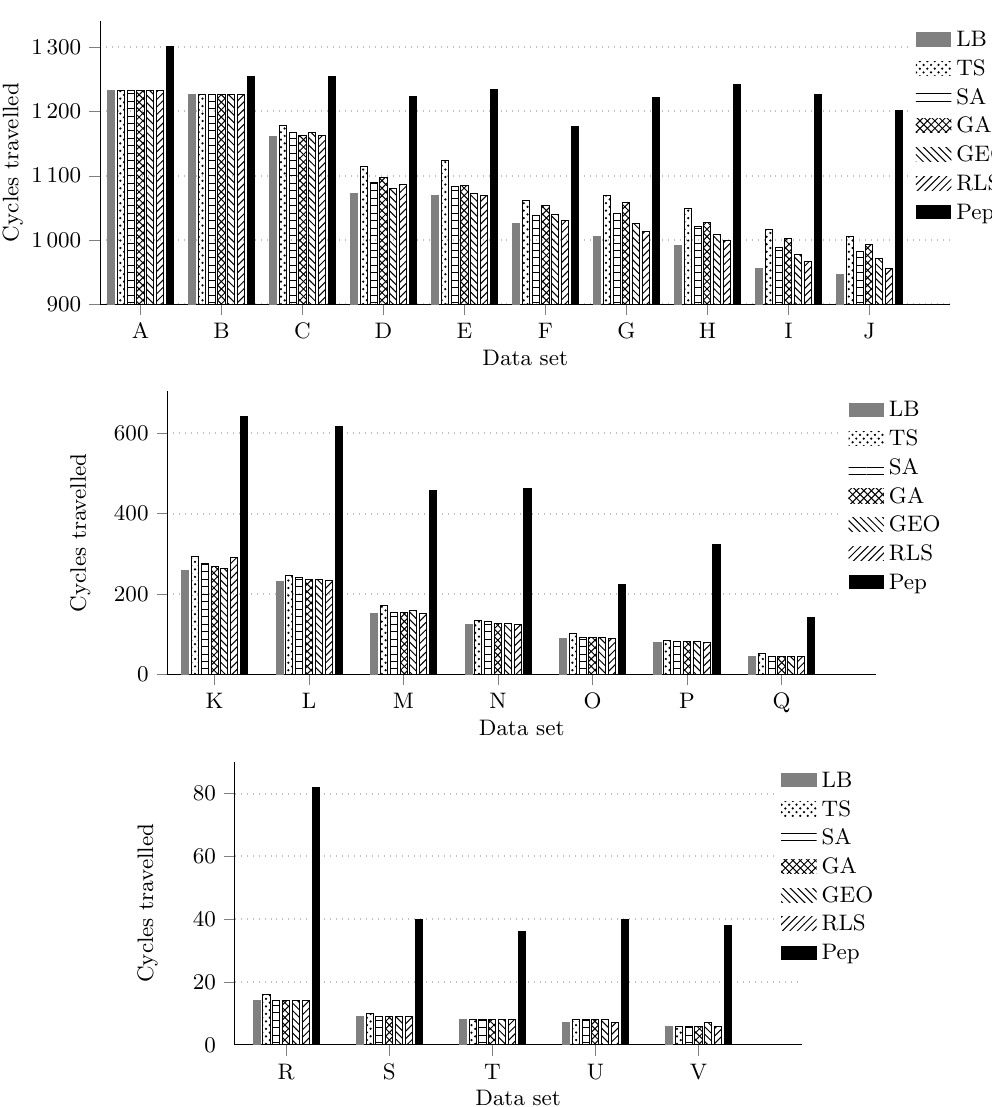
Figure 5: A bar chart displaying the results (cycles travelled) obtained in Table 1. The number of cycles travelled for the lower bound (LB), tabu search (TS), simulated annealing (SA), genetic algorithm (GA), generalised extremal optimisation (GEO) and random local search (RLS) for each data set are compared to the historical results from